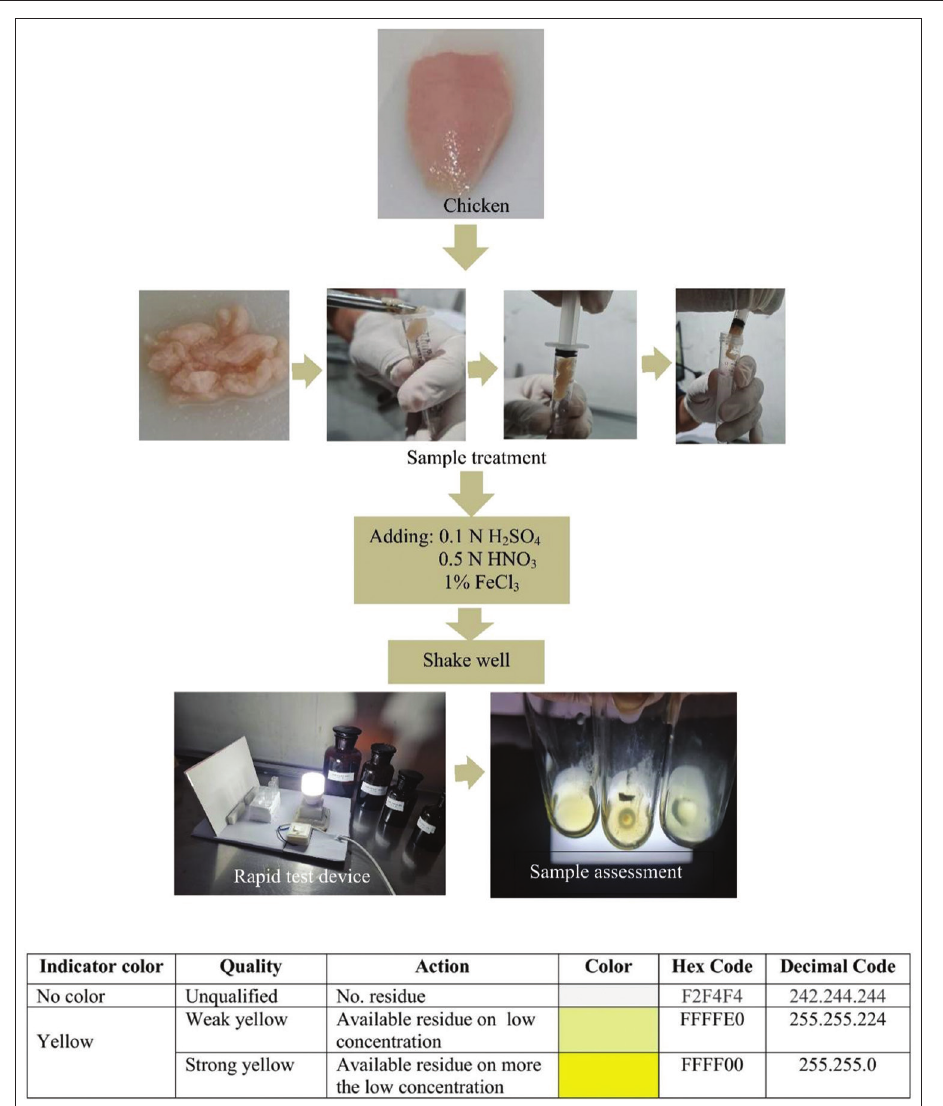
Figure-1: Protocol research and criteria indicator color of rapid test Devices on expose light-emitting diode and HyperText Markup Language